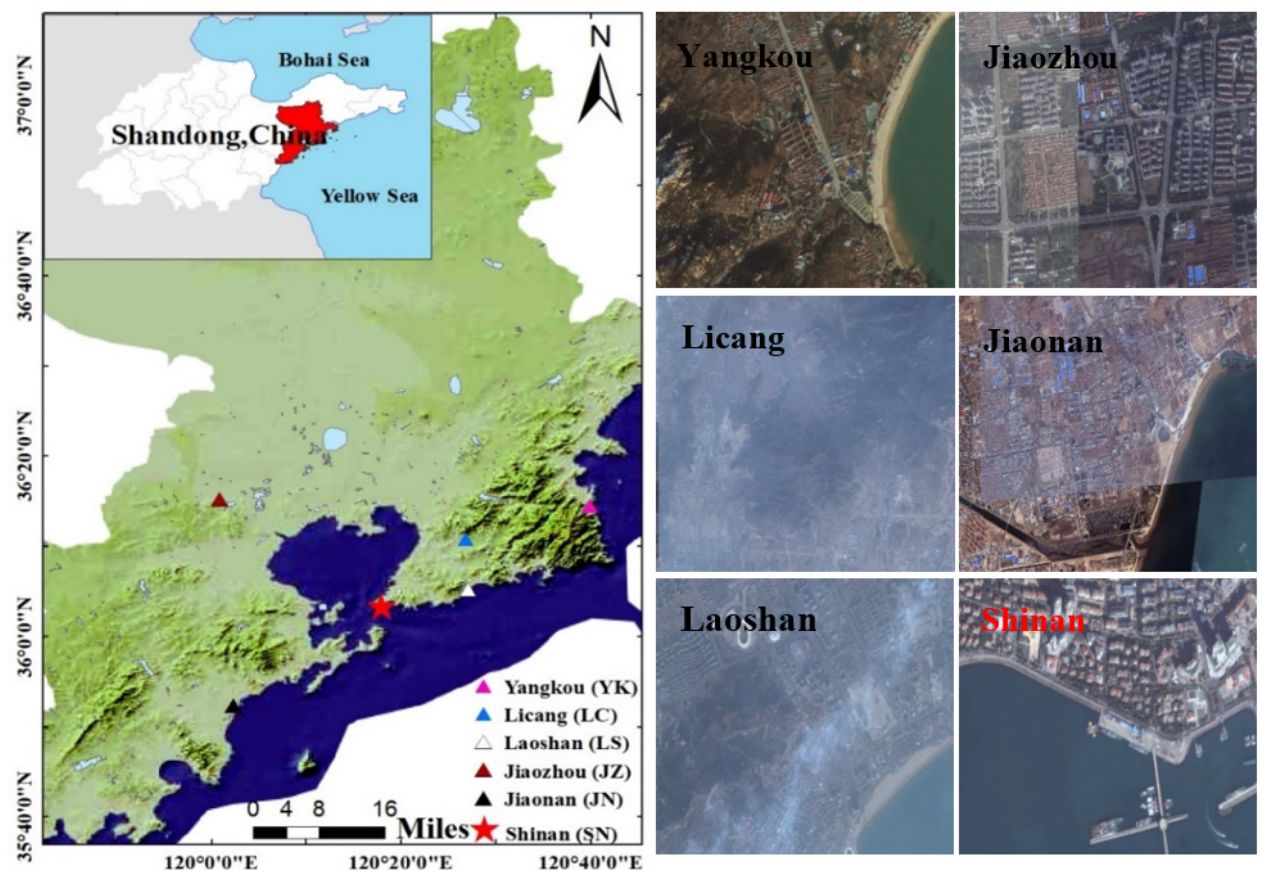
Figure 1. Map of the sampling site.